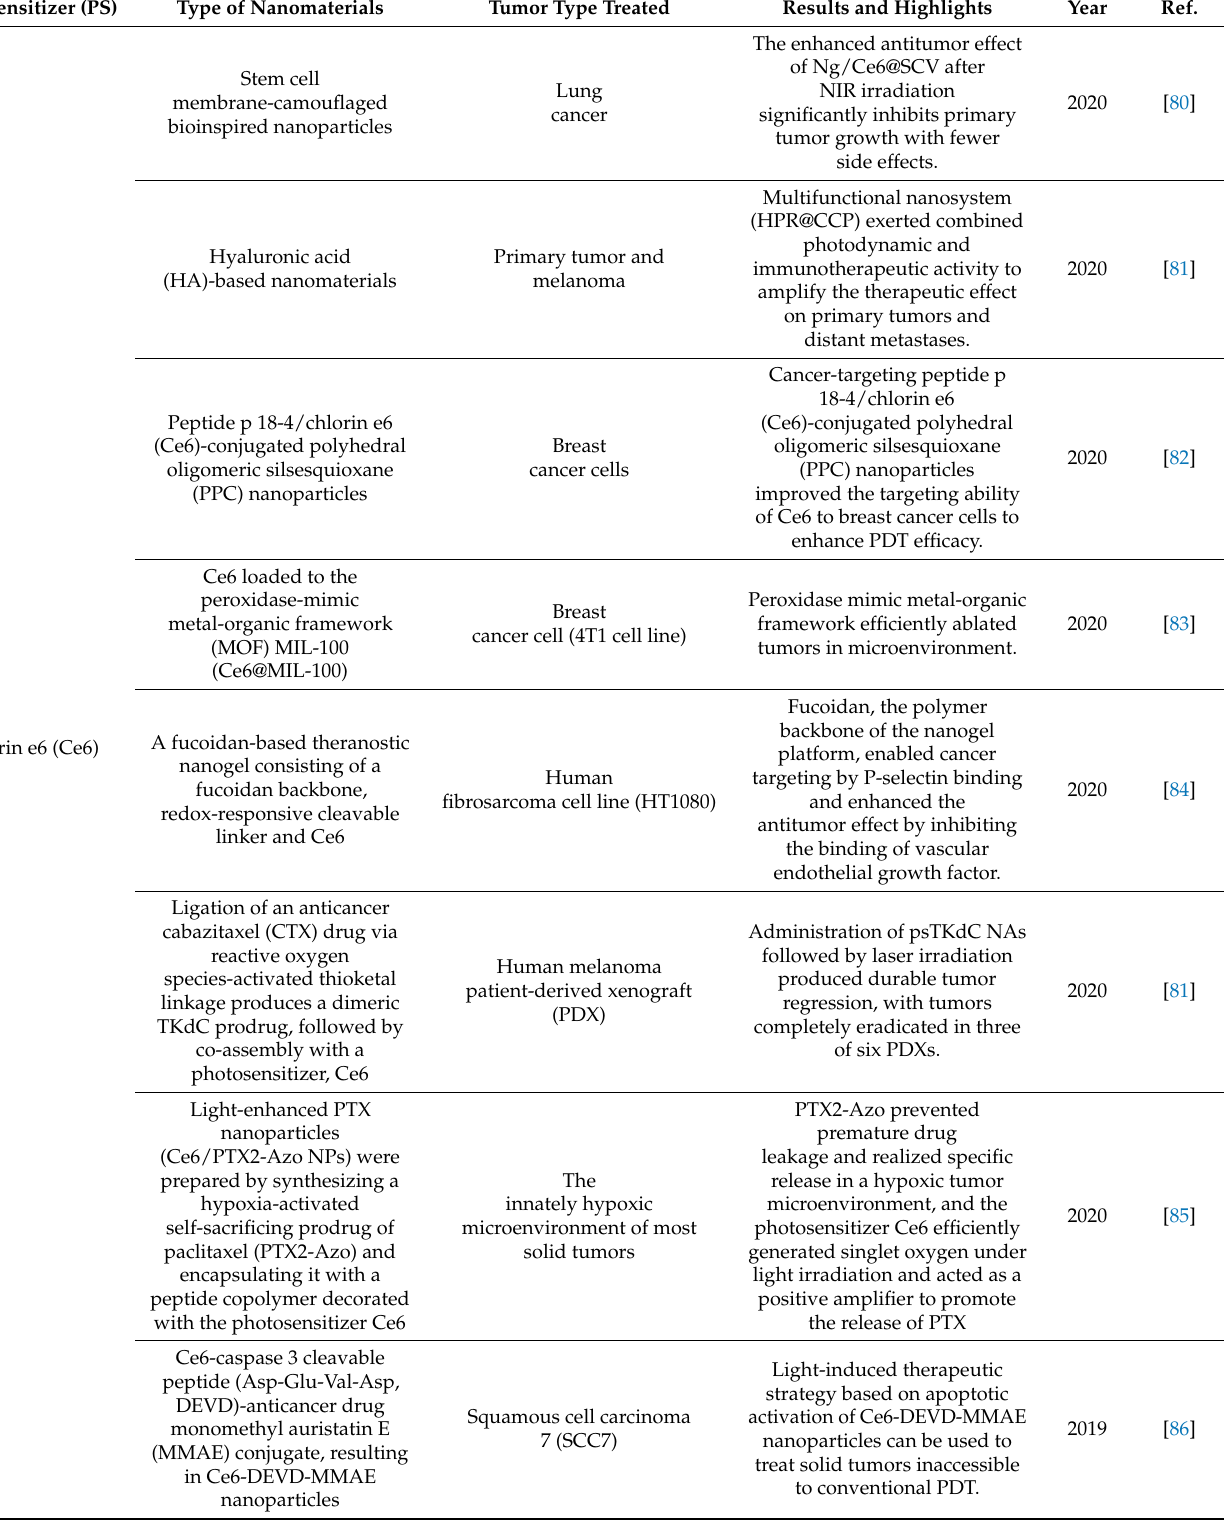
Table 2. Recent advances in the preclinical development of nanopharmaceuticals to perform PDT. Photosensitizer